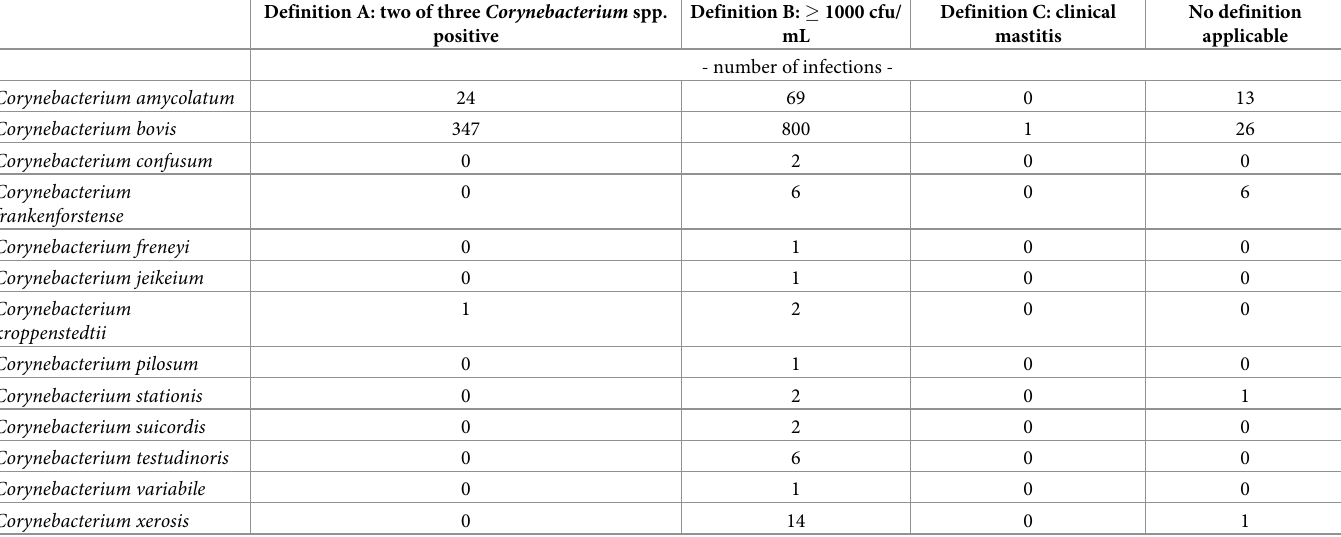
Table 2. Number of observed Corynebacterium spp . IMIs according to the infection definitions A, B and C. Definition A: two of three Corynebacterium spp.